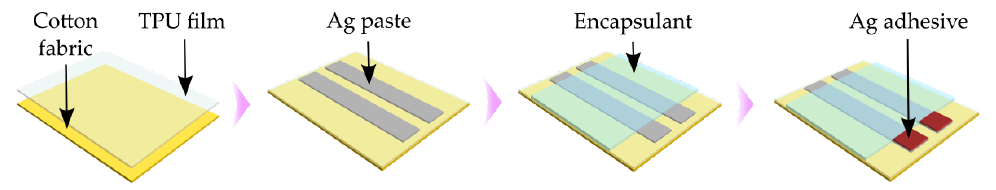
Figure 1. Fabrication steps of a textile-based skin hydration sensor.